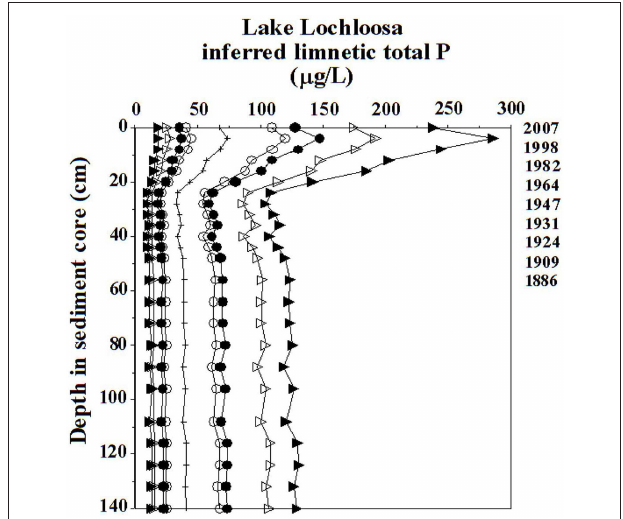
FIGURE 2 | Confidence intervals for diatom-based inferred limnetic total P values for the Lake Lochloosa core. Hatched lines: inferred means. Open circles: 68% confidence intervals ( ± 1 SE) for the model. Closed circles: 95% confidence intervals ( ± 1.96 SE) for the model. Open triangles: 68% confidence intervals based on bootstrapping. Closed triangles: 95% confidence intervals based on